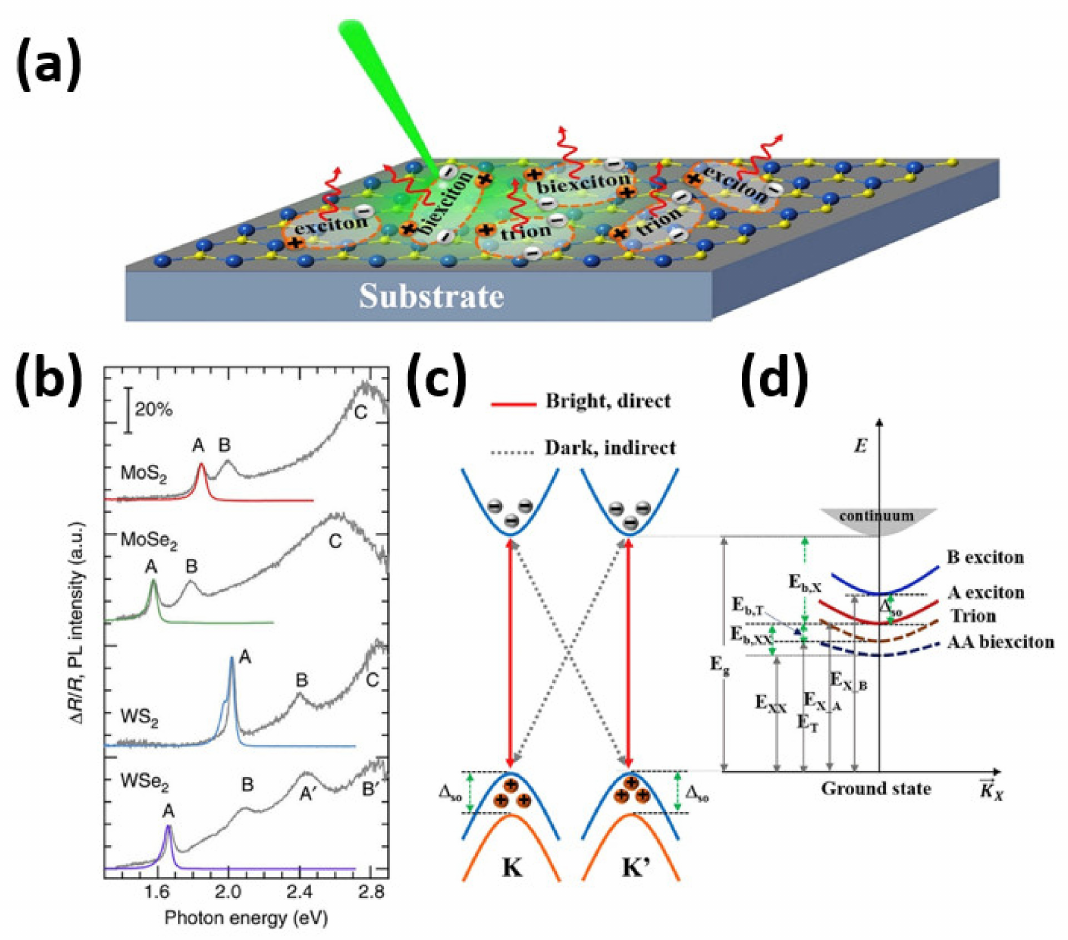
Figure 5. ( a ) Schematic of exciton, trion, biexciton generation in TMDs by photoexcitation. ( b ) PL and differential reflectance spectra of monolayer TMDs flakes on quartz substrate. ( c ) The four possible exciton formations in K and K (cid:48) valleys. ( d ) The bound electron-hole pair in exciton picture. [62] Figure reproduced with permission from